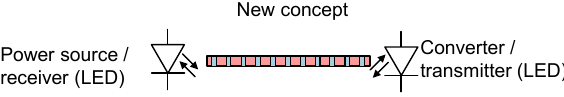
Figure 3. New concept using identical LEDs as power source and data receiver as well as power converter and data